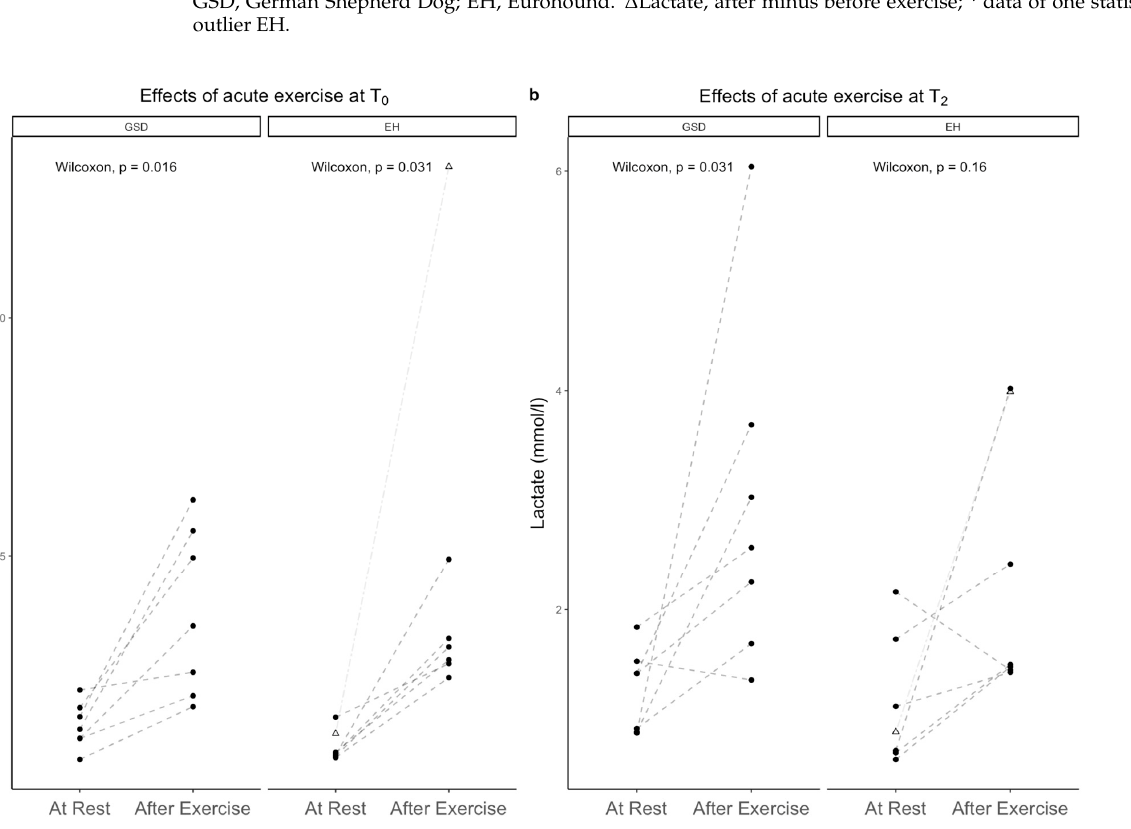
Figure 4. Effects of exercise on Lactate in GSD and EH at T 0 ( a ) and T 2mth ( b ). EH: Eurohounds; GSD: German shepherd dogs; Δ : values of EH α , outlier EH.